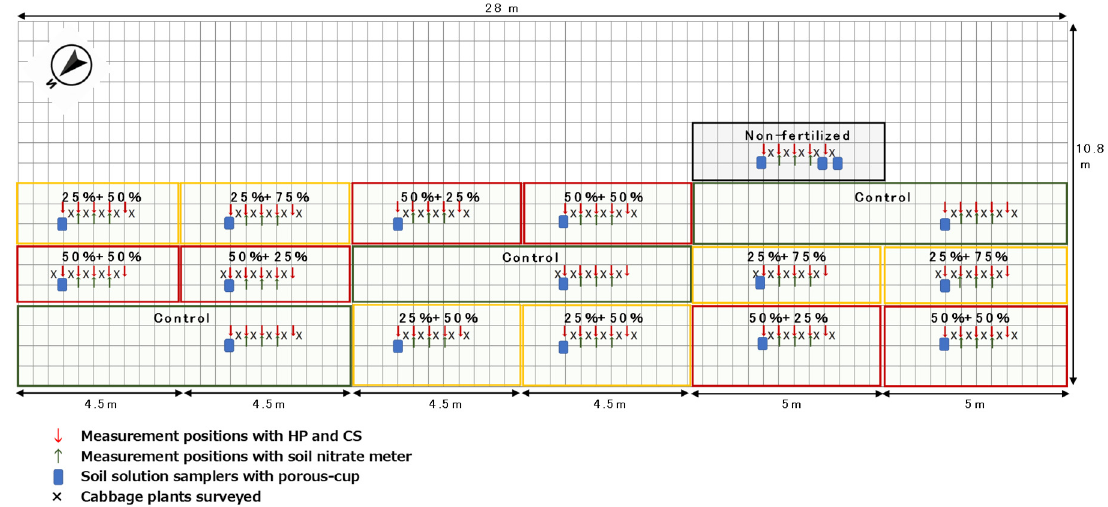
Figure 1. Layout of treatments and sensing positions (Trial 3). HP, HydraProbe; CS, CS655. Crop residue compost was applied at 2000 g m − 2 on 21 February 2022, and magnesium carbonate fertilizer of 111 g m − 2 was applied on 22 February 2022. Basal fertilizer was applied to each plot 2 days before transplantation. A control plot was treated only with basal fertilizer using slow-release fertilizer (CDU-S555) at 30 g N m − 2 , 30 g P 2 O 5 m − 2 , and 30 g K 2 O m − 2 . To provide variable-rate N top dressing plots, the amount of basal fertilizer was set at two levels, 25% or 50% of the N in the control plot. The N fertilizer was applied as granular urea (N 46, Mitsui Chemicals Inc., Tokyo, Japan) in amounts equivalent to 7.5 g N m − 2 at 25% and 15 g N m − 2 at 50%. Phosphoric acid and potassium were applied as a complex fertilizer (Mitsui PK, P 2 O 5 -K 2 O=15-15, Kantodenko Co., Ltd., Takasaki, Japan) in amounts equivalent to 30 g P 2 O 5 m − 2 and 30 g K 2 O m − 2 for all plots except the non-fertilized